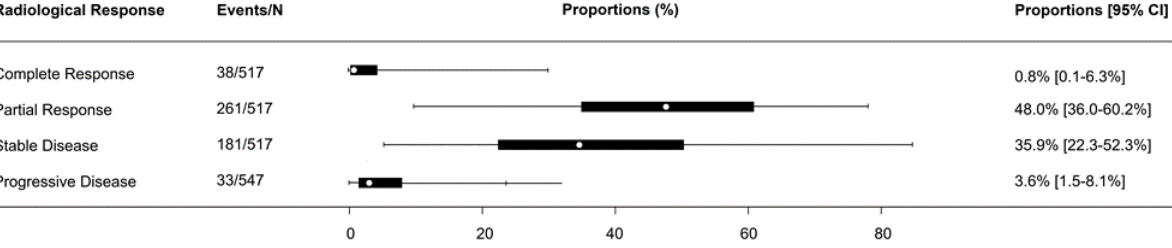
Figure 1. Forest plot summarizing the proportion of patients with radiological response after neoadjuvant immunotherapy for resectable non-small cell lung cancer.